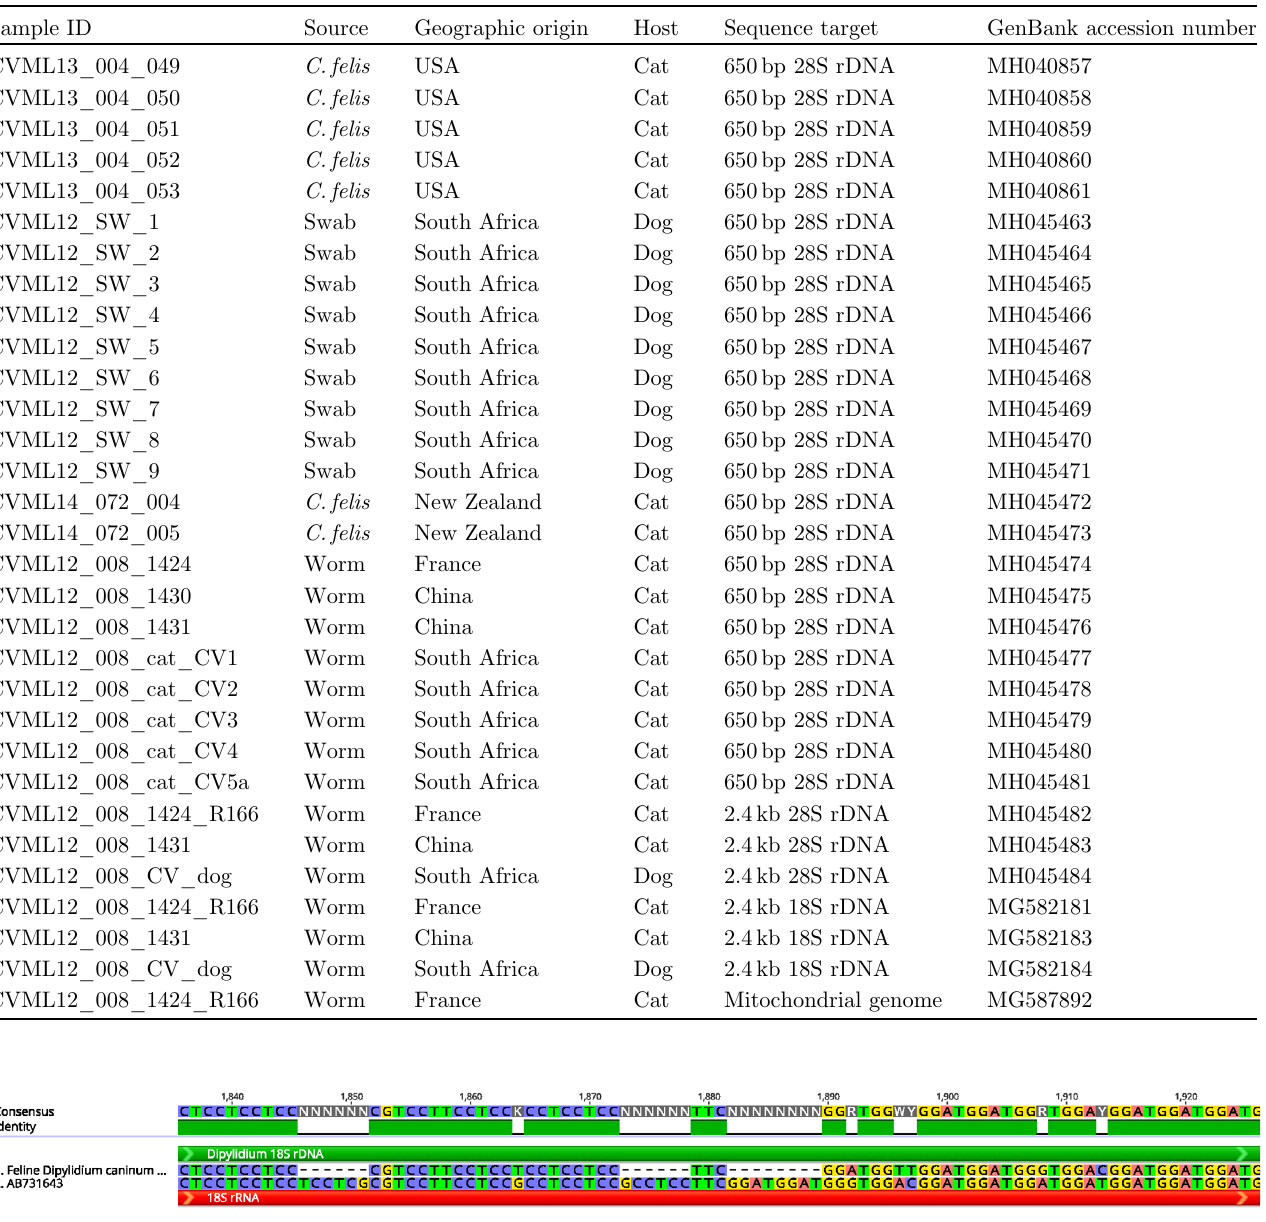
Figure 1. Conserved insertion/deletion events (indicated by (cid:3) ) present in the 18S rDNA feline genotype representing feline associated D.caninum (bottom sequence) when compared to the canine genotype (second sequence from the bottom) representing the canine associated D.caninum